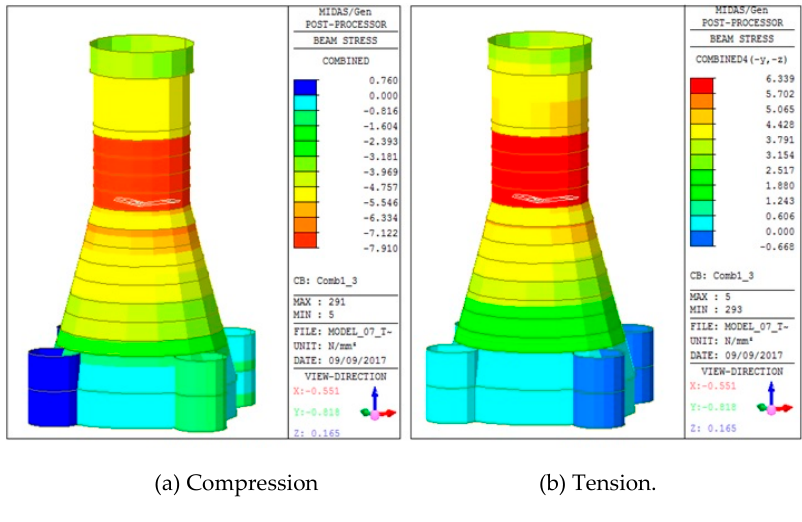
Figure 11. Stress distributions on DLC6.2da.